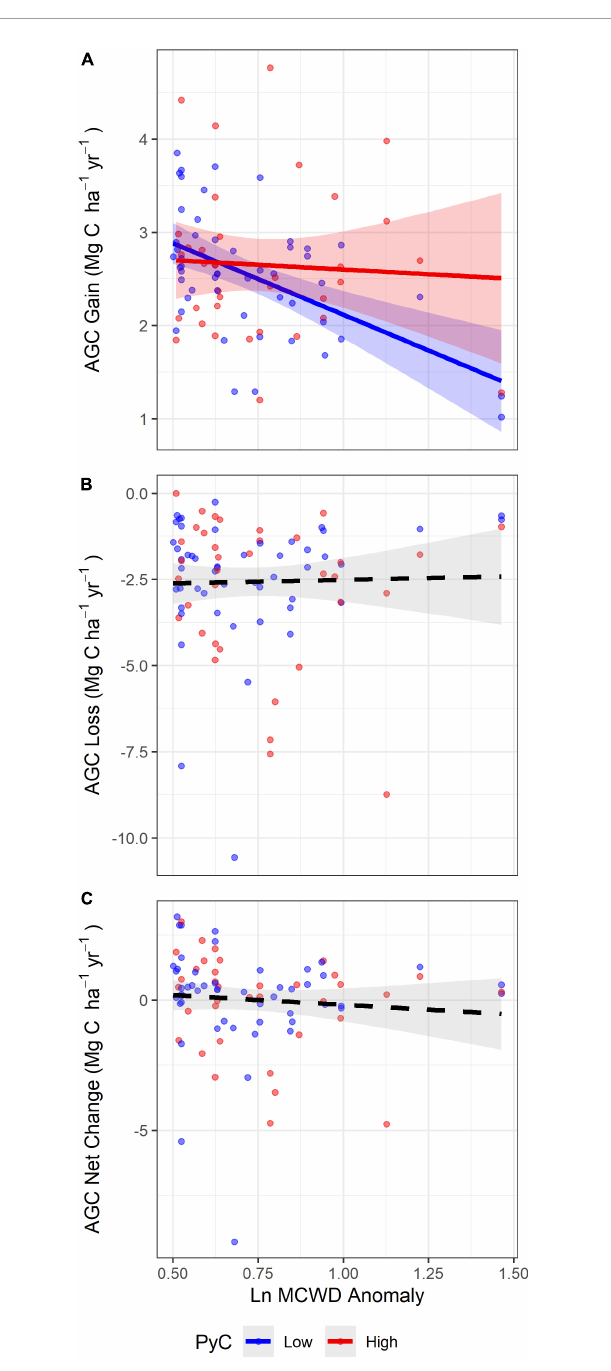
FIGURE5 The relationship between soil PyC and (A) AGC gains, (B) AGC losses and (C) AGC net change with drought severity (MCWD anomaly). Blue lines and dots represent plots classified as low percentage of PyC in soil ( < 0.048%) and red as high percentage of PyC in soil ( ≥ 0.048%). Solid lines represent significant relationships between MCWD anomalies and AGC dynamics, whilst different slopes between blue and red lines represent a significant interaction between soil PyC and MCWD anomaly in the best model ( p < 0.05). Dashed lines represent non-significant relationships between variables. Shading denotes the 95% confidence interval. The MCWD anomaly is log transformed.